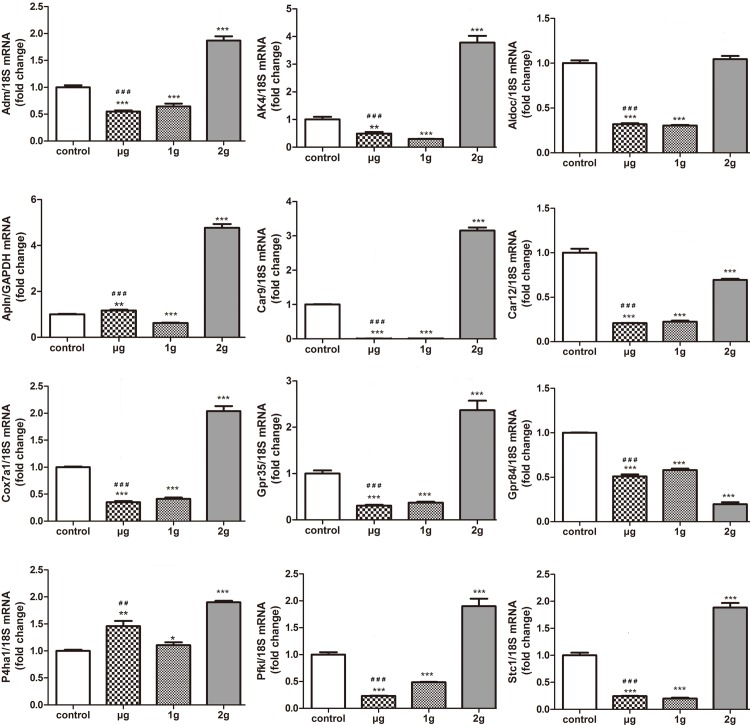
Microarray results were verified using real-time PCR for genes in response to LG-HMF.Total RNA was extracted and qPCR assay was used to further identify for 12 selected genes. The method of relative quantification was used to estimate the relative expression changes of selected gene expression in MLO-Y4 cells exposed to LG-HMF. The changes in selected gene expression, normalized to 18S under LG-HMF were calculated. The difference between μ-g v.s. control, μ-g v.s. 2- g, and 1- g v.s. control was statistically analyzed by one-way ANOVA. μ - g, 1-g, 2 - g v.s control group: ***P< 0.001; **P< 0.01; *P< 0.05. μ - g v.s 2 - g group: ###
P < 0.001; ##
P < 0.01.